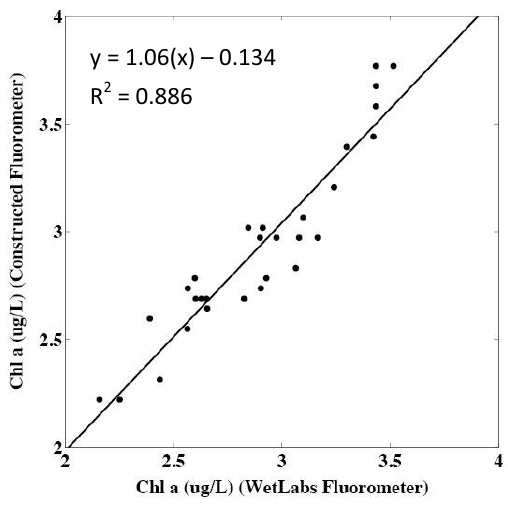
Figure 8 . Comparison of chlorophyll a concentration measured by WetLabs WETStar and the constructed fluorometer in The Damariscotta River Estuary (08/01/12–08/02/12). The outputs from both sensors were normalized to extracted chlorophyll a measurements taken from water collected during the deployment. y = 1.06(x) –